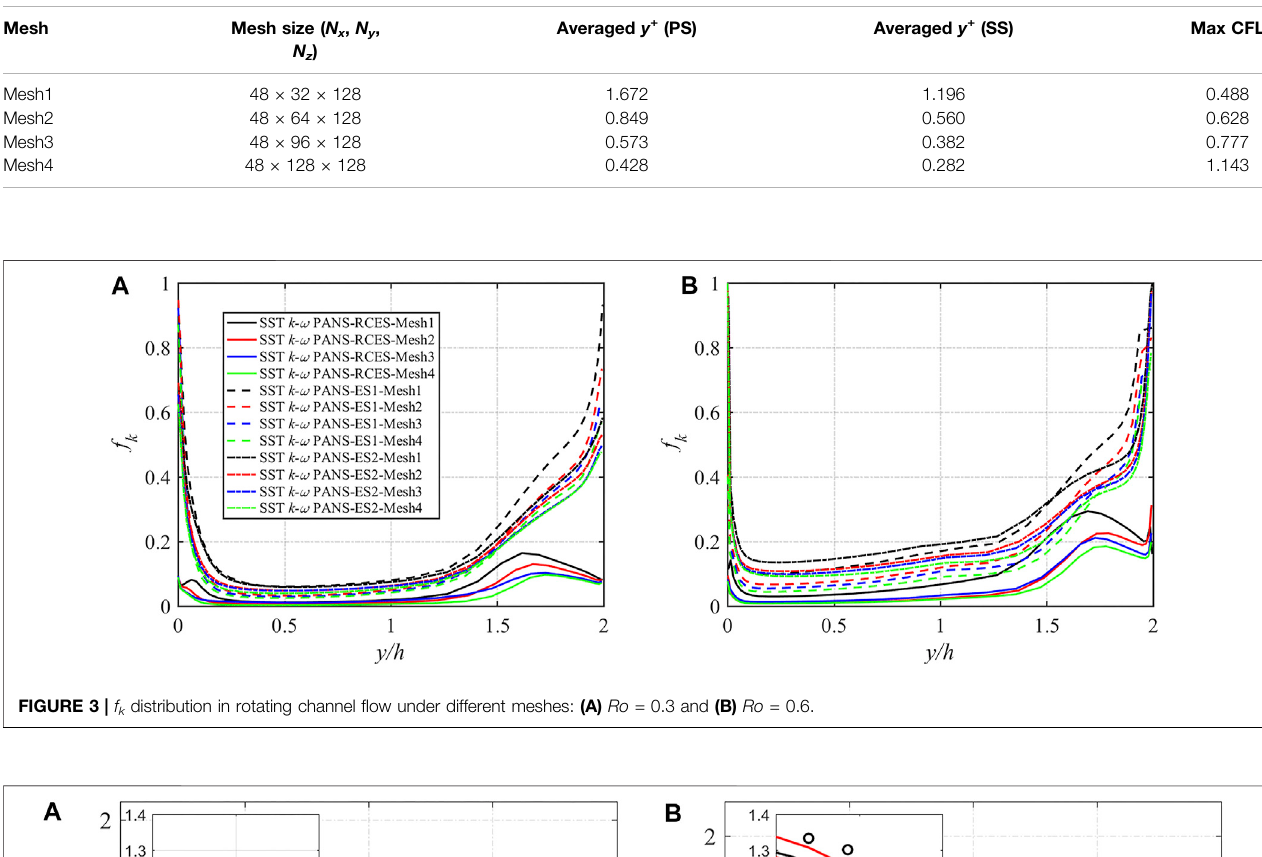
Frontiers in Energy Research |